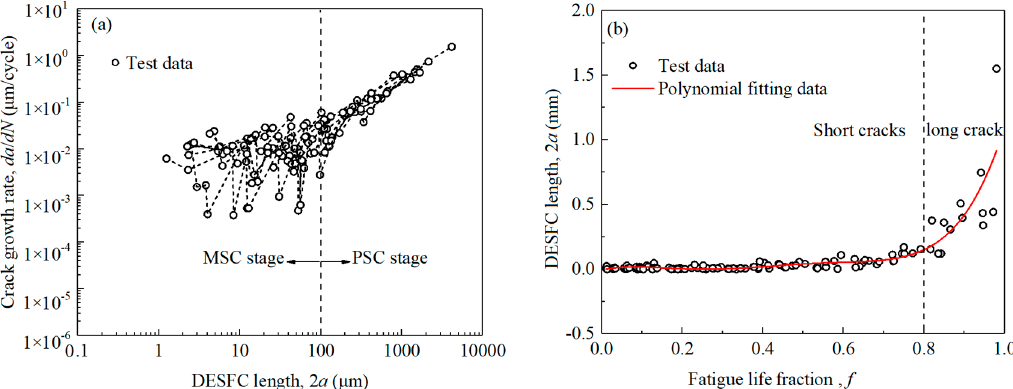
Figure 5. The relationship between the dominant effective short fatigue crack (DESFC) length and ( a ) the crack growth rate, and ( b ) the fatigue life fraction, which is the ratio of cycles number to fatigue life.